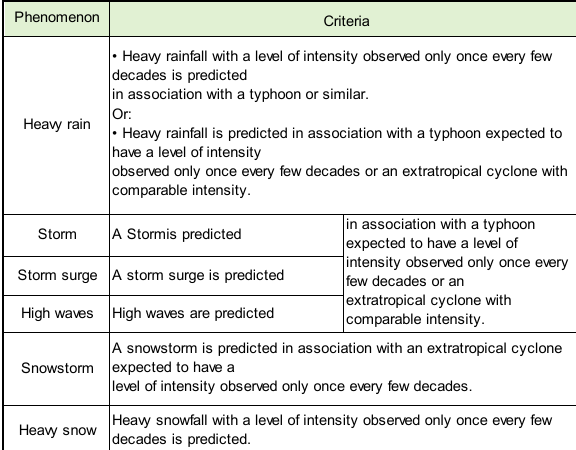
Table 5. JMA Criteria for Emergency